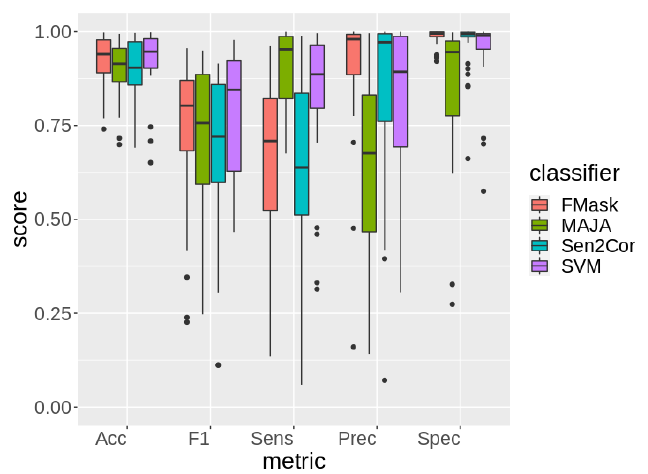
Figure 5. Performance estimation, on the independent test set, of FMask, MAJA, Sen2Cor and SVM in terms of each classification metric. The classification metrics are evaluated over the 29 scenes of D 3 .